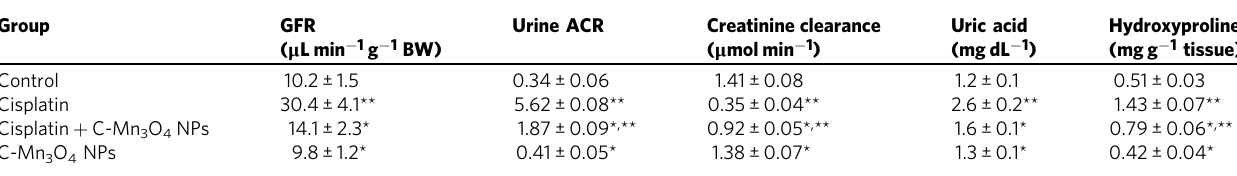
Table 1 Effect of C-Mn 3 O 4 NPs on nephrotoxic biomarkers.